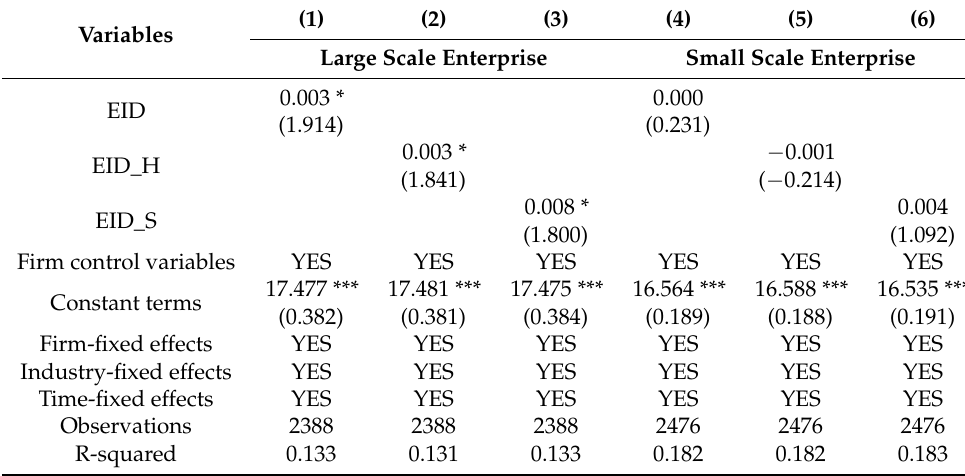
Table 6. Heterogeneity analysis: differences in firm